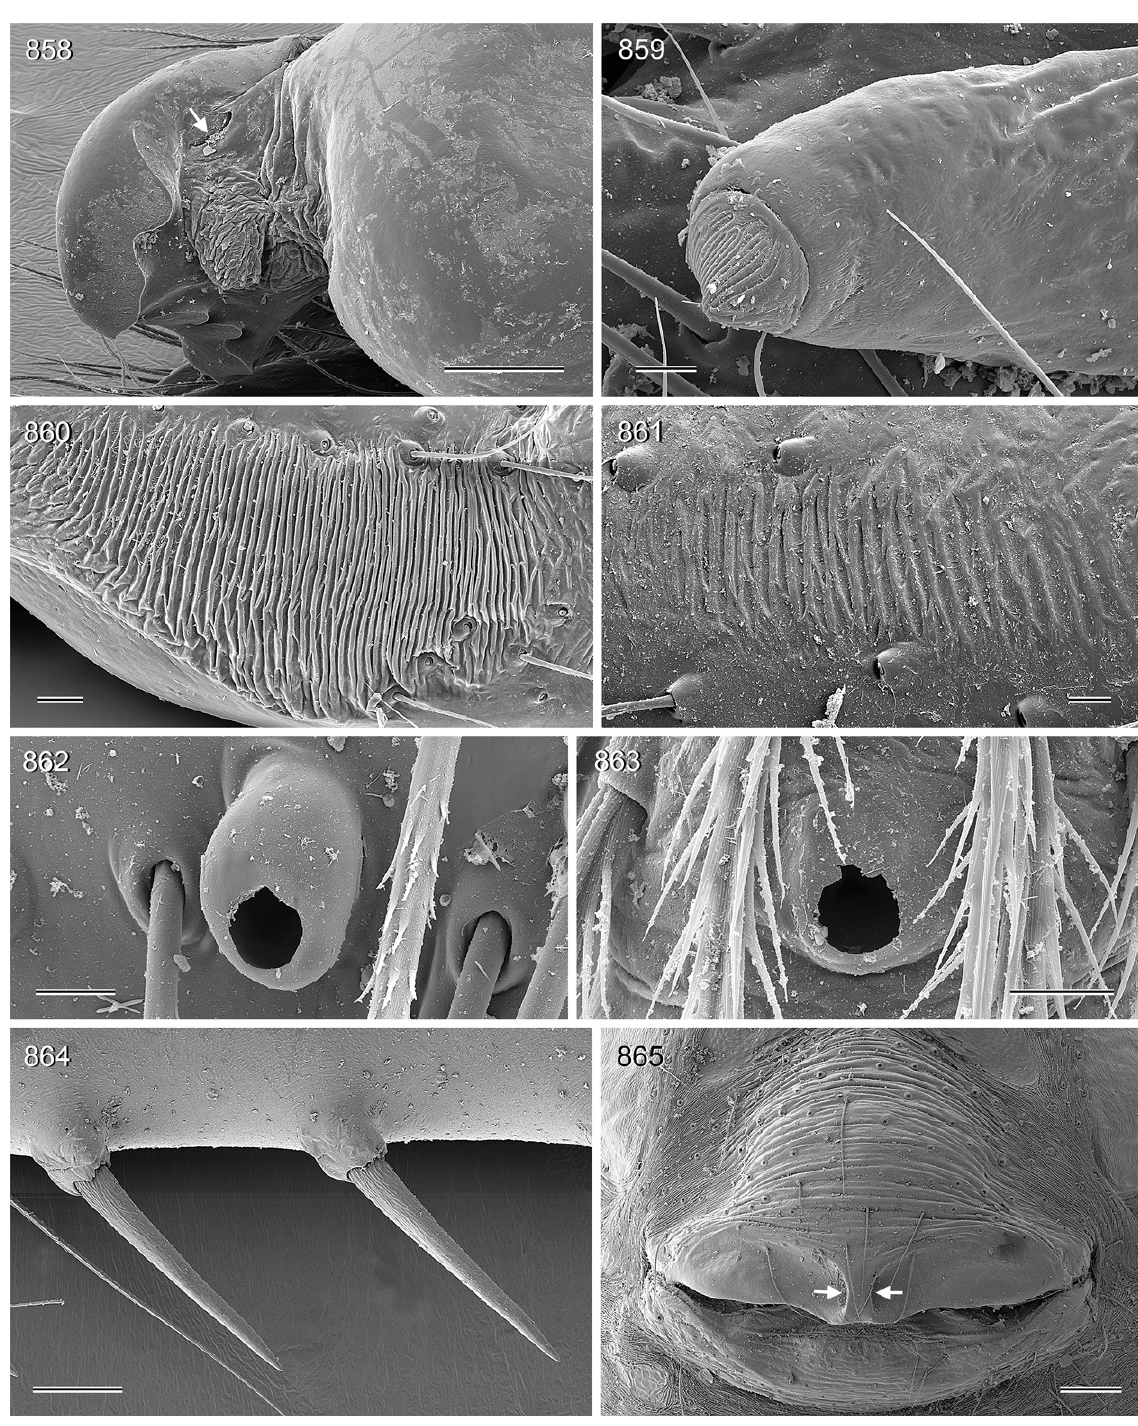
Figs 858–865. Crossopriza maculipes (Spassky, 1934); male and female from Afghanistan, Djelalabad (MHNG). 858 . Right genital bulb, prolateral (slightly ventral) view; arrow: sperm duct opening. 859 . Tip of male cheliceral apophysis. 860–861 . Male and female cheliceral stridulatory files. 862 . Male palpal tarsal organ. 863 . Tarsal organ on male tarsus 1. 864 . Spines on male femur 1. 865 . Epigynum; arrows: pockets. Scale bars: 858, 864–865 = 100 µm; 859, 861–863 = 10 µm; 860 = 20